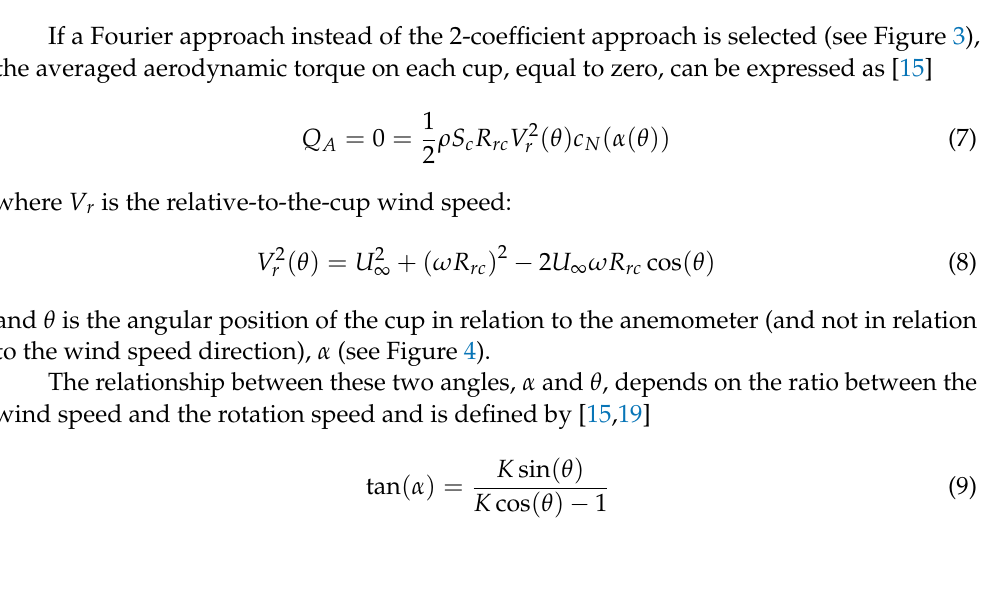
Figure 3. Coefficient c N , measured on static cups by Brevoort and Joyner [32] in relation to the cup yaw angle (see the sketch added to the figure). The 2-coefficient approach and the 1-harmonic Fourier approach to these experimental measurements are included in the graph.